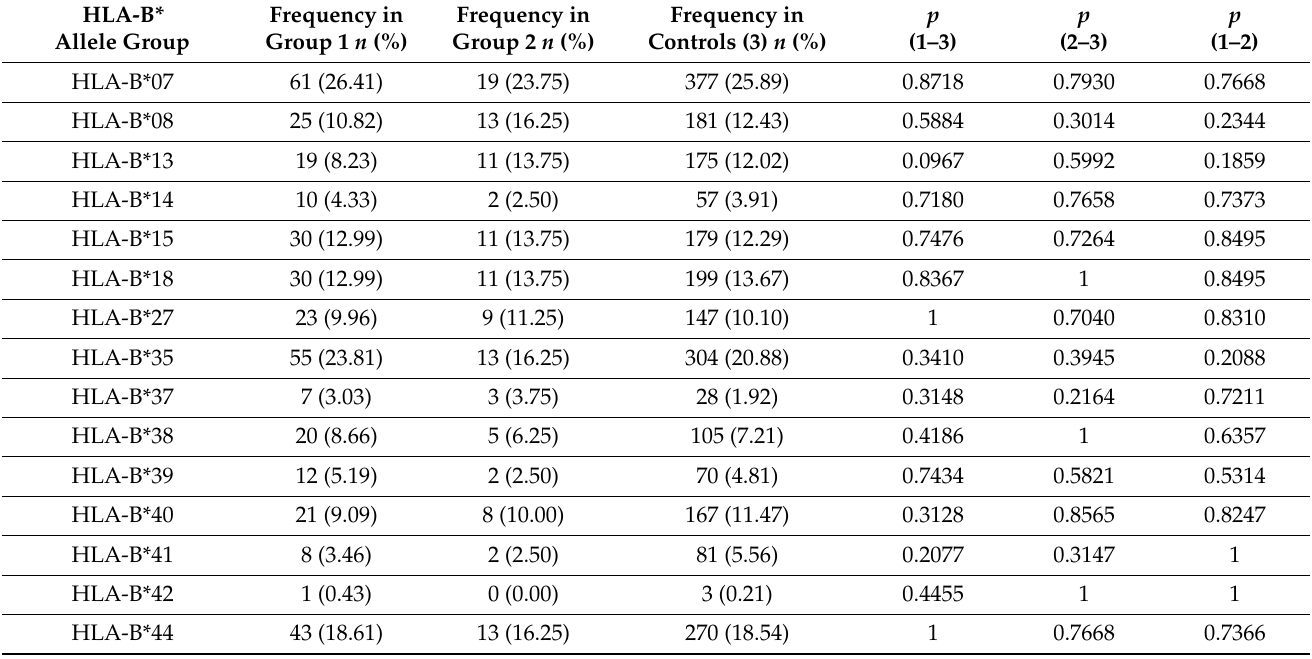
Table 5. Frequency of HLA-B* allele groups in the 1st ( n = 231) and 2nd ( n = 80) COVID-19 convales- cent groups compared with controls ( n =